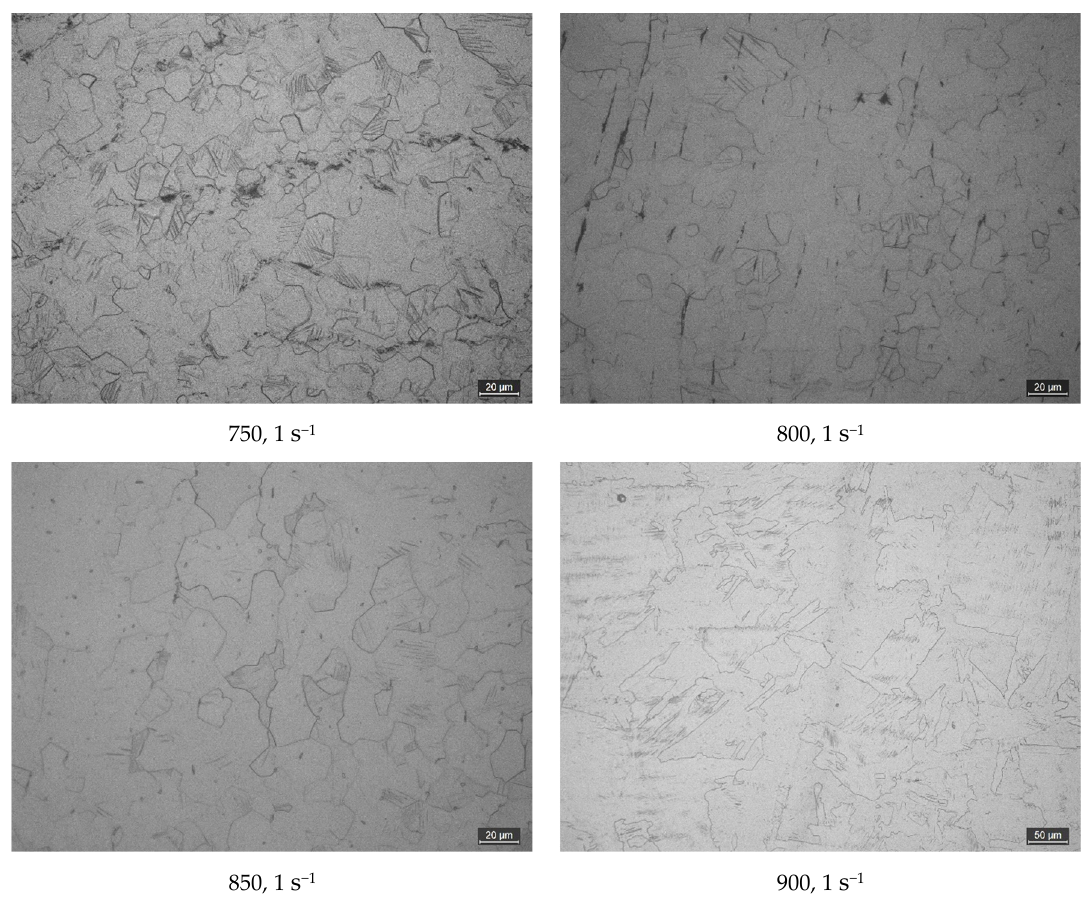
Figure 2. The curves of true stress and true strain at different temperatures: ( a ) 700 °C; ( b ) 750 °C; ( c ) 800 °C; ( d ) 850 °C; ( e ) 900 °C.